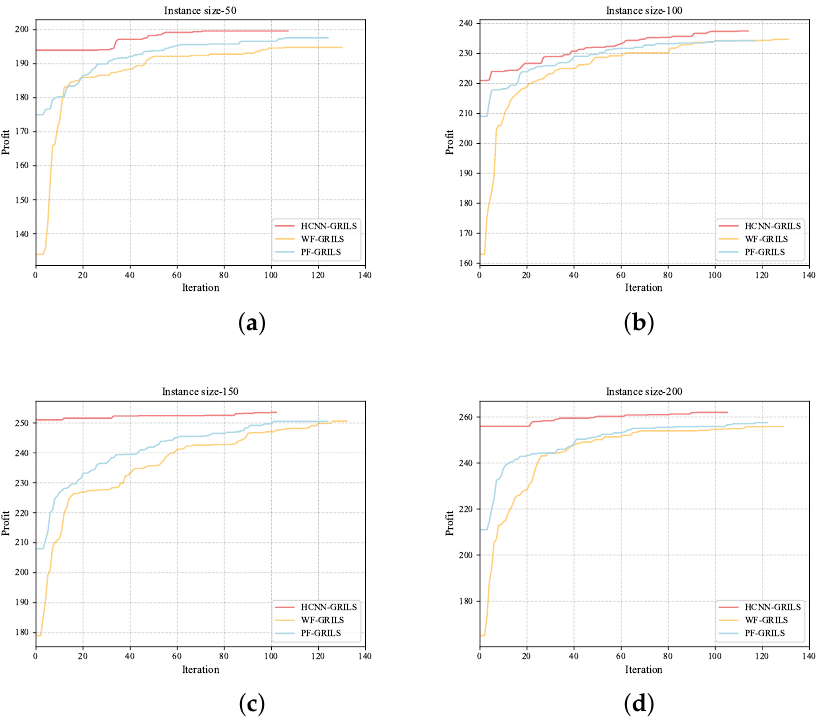
Figure 12. Interactions of GRILS at different sizes. ( a ) Interactions of GRILS at size 50. ( b ) Interactions of GRILS at size 100. ( c ) Interactions of GRILS at size 150. ( d ) Interactions of GRILS at size